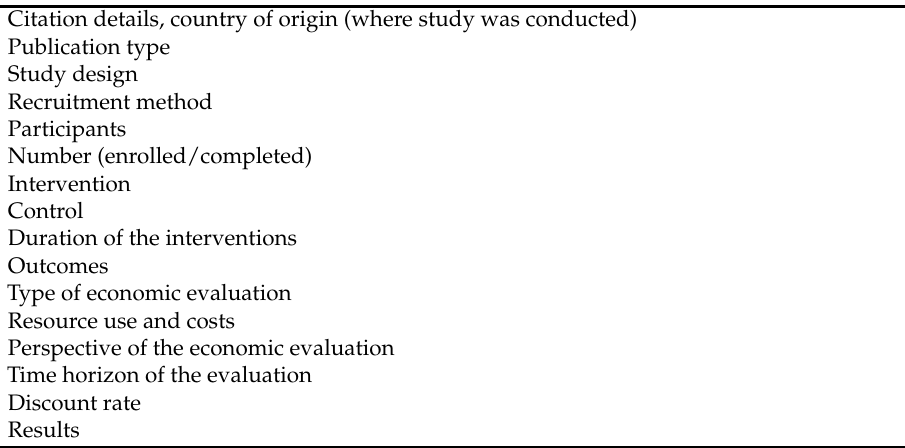
Table 1. Data extraction template.